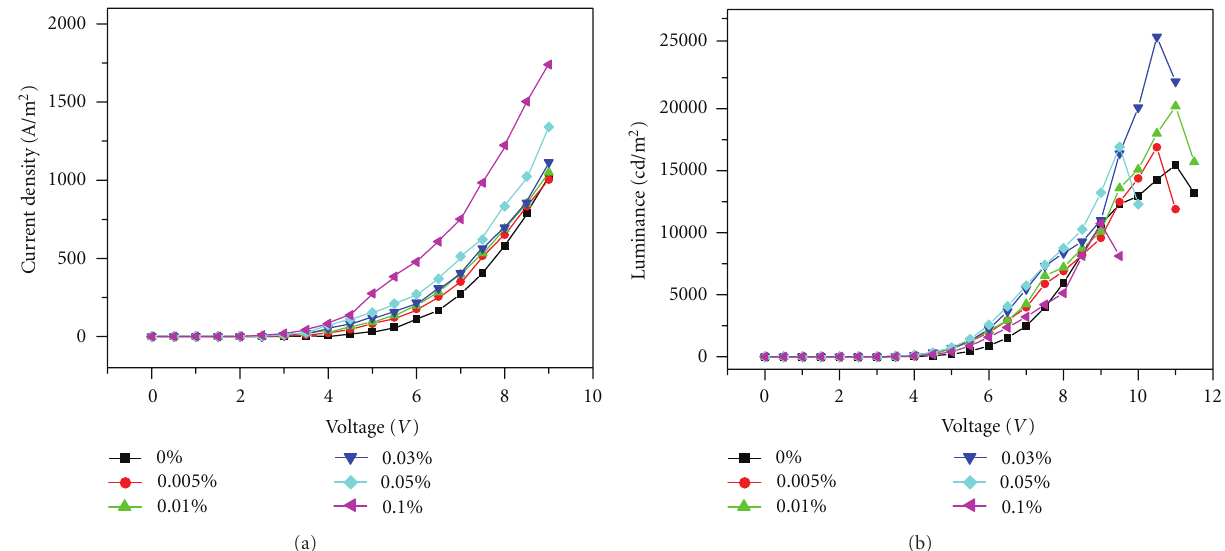
Figure 4: The e ff ect of graphene concentration on the J-V curves (a) and L-V curves (b) of PLED using PEDOT:PSS/graphene nanocomposite as the hole-injection layer.